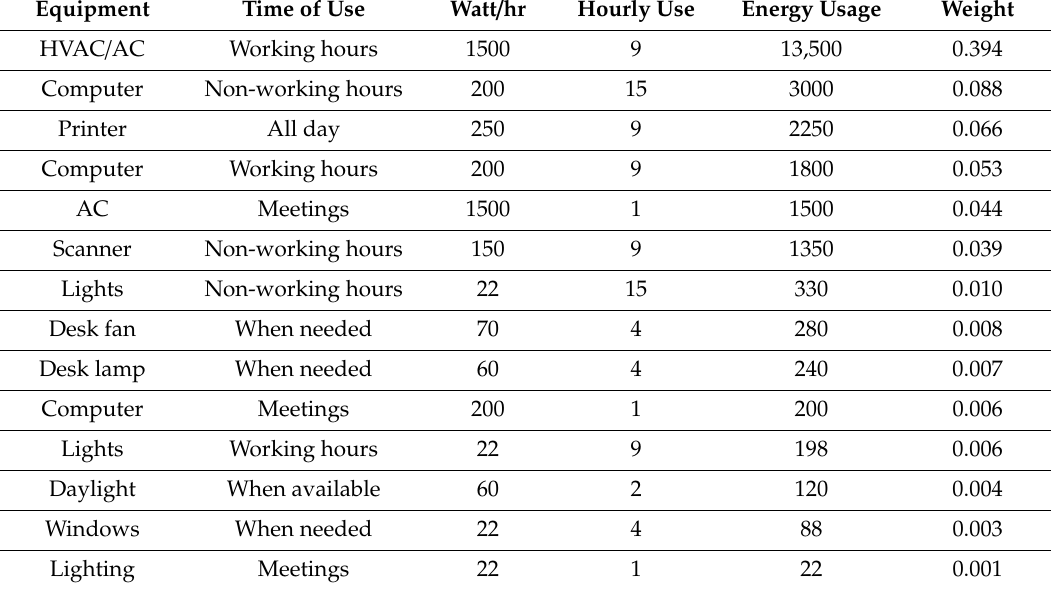
Table 6. Ranking of equipment energy usage based on energy usage.